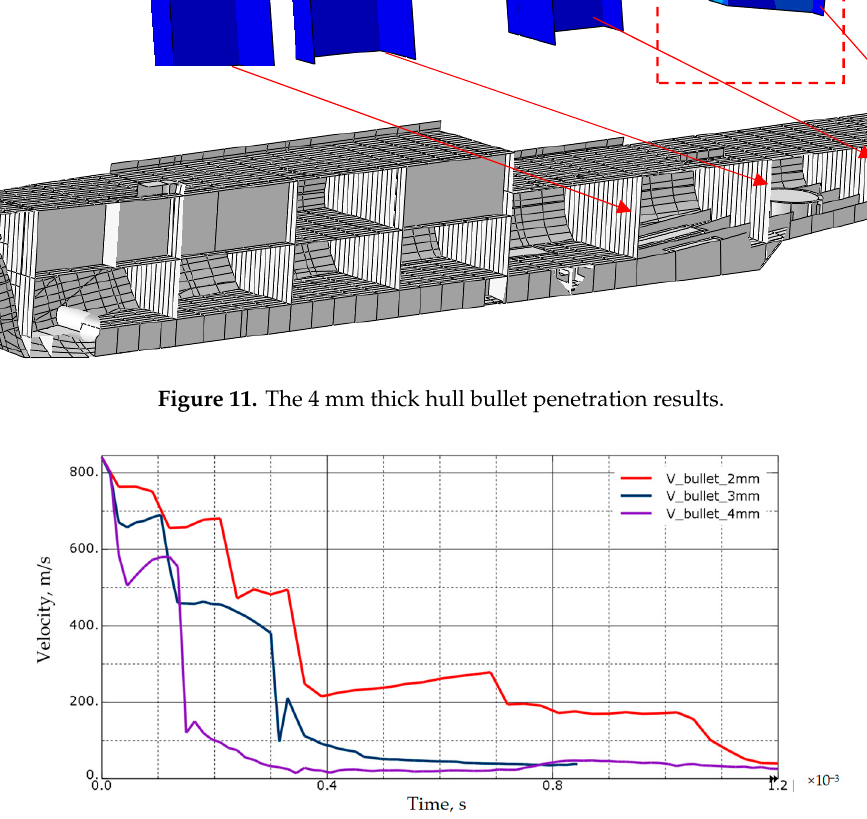
Figure 12. Projectile velocity decrease for different hull plating thicknesses.